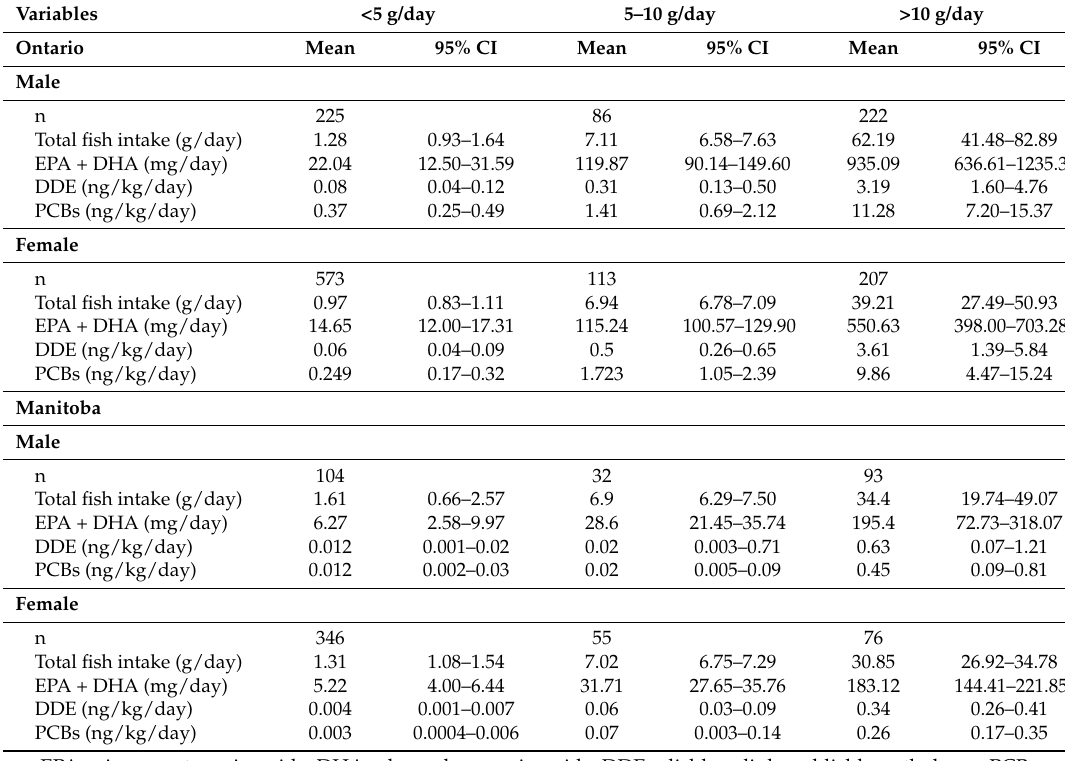
Table 3. Dietary EPA + DHA and POP intake by three categories of fish